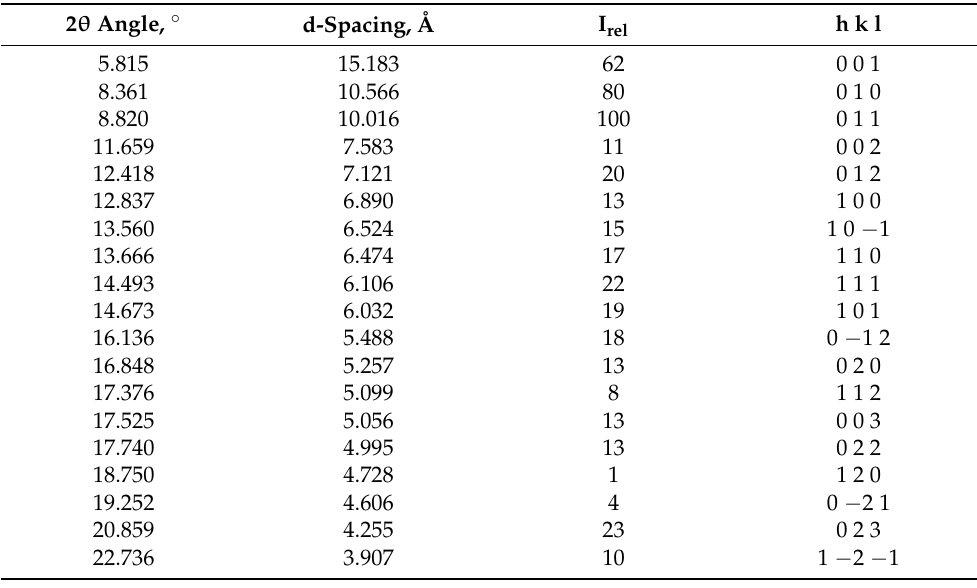
Table 11. List of observed 2 θ angles, d-spacings, and relative intensities, jointly with reflection indices, for Eltrombopag Form